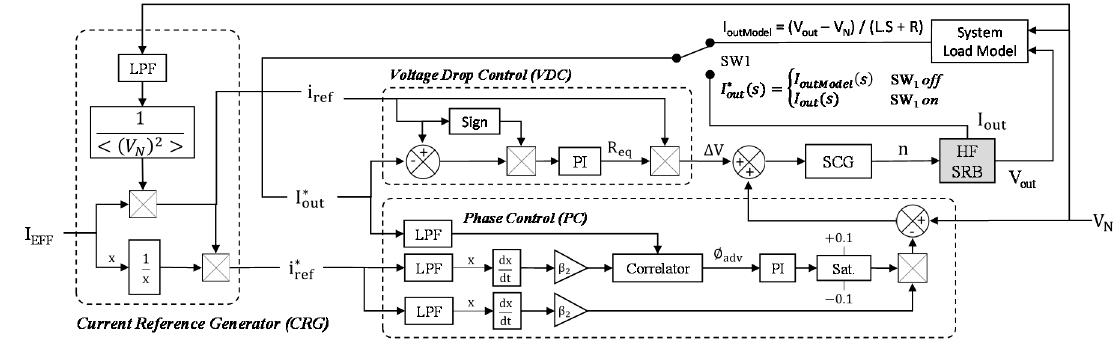
Figure 6. Synoptic bloc of the discharge control system.